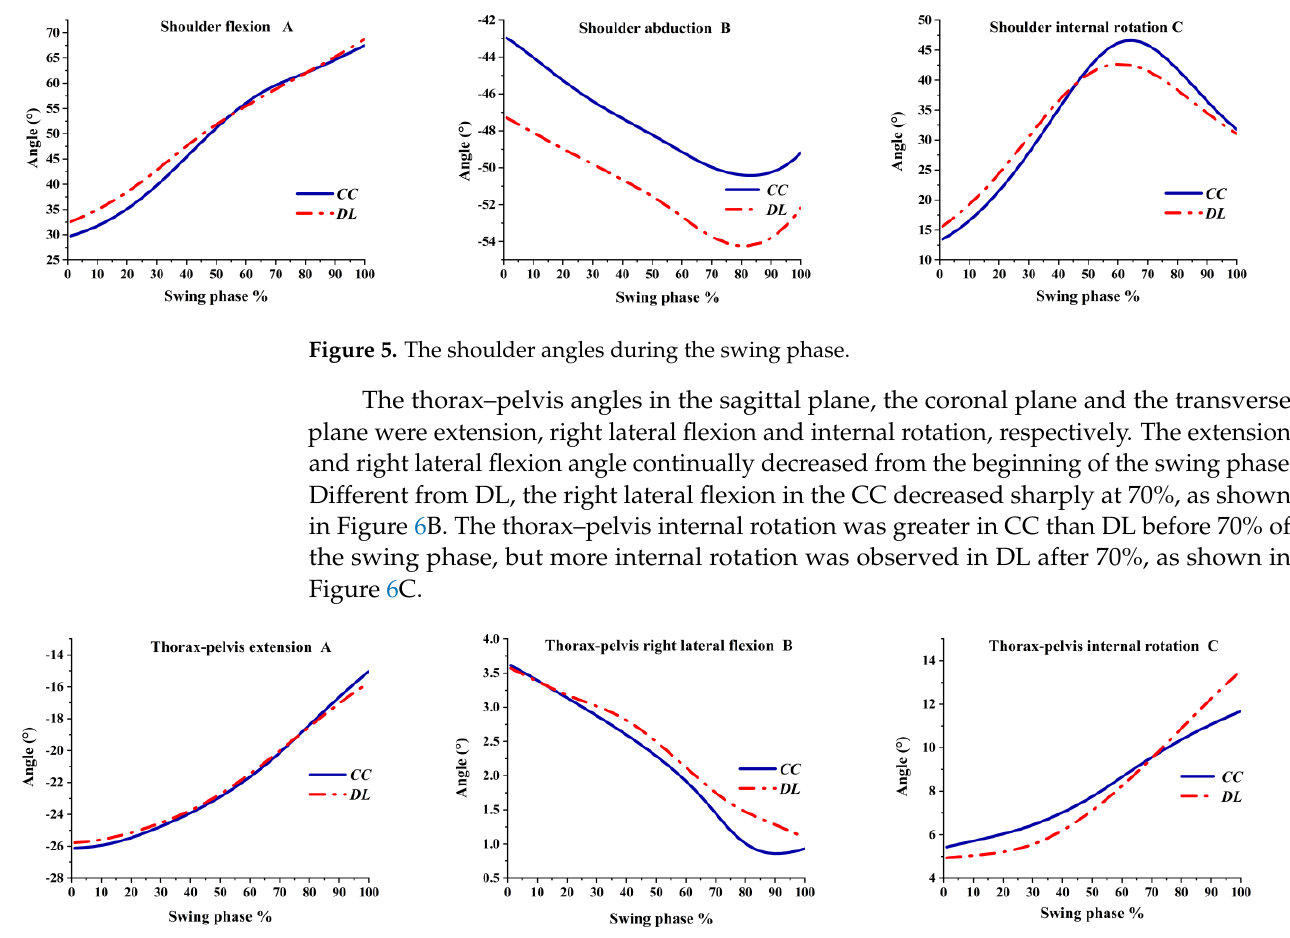
Figure 6. The pelvis – thorax angles during the swing phase.